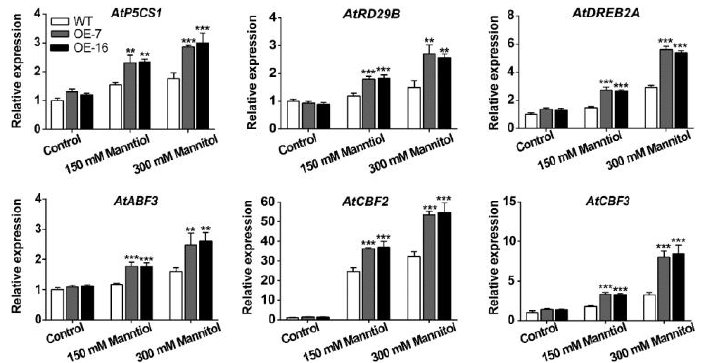
Figure 8. The transcriptional levels of stress-related genes in TaWRKY46 -overexpressing Arabidopsis plants after 0, 150 and 300 mM mannitol treatments for 10 days. Asterisks indicate a significant difference between WT and transgenic Arabidopsis lines (** p < 0.01; *** p < 0.001).